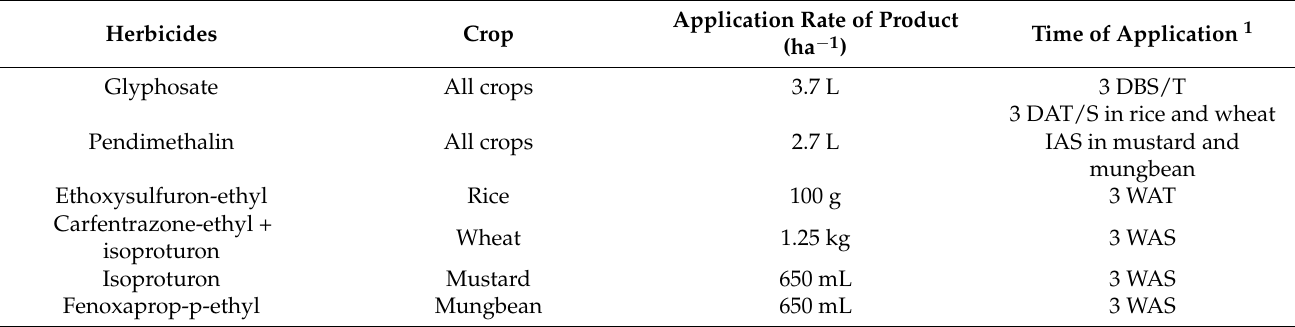
Table 2. List of herbicides used to control weeds in different crops under